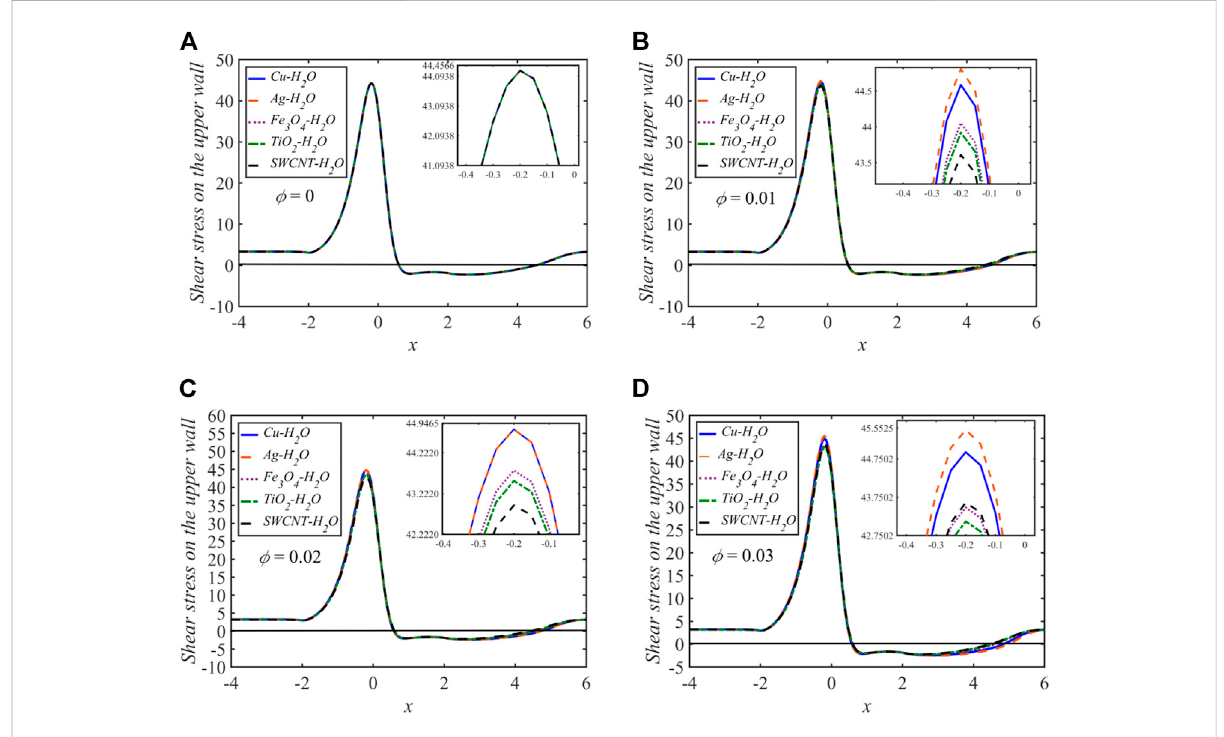
The WSS distribution for distinct values of ϕ for the fi ve NFs at t (cid:2) 0 . 25